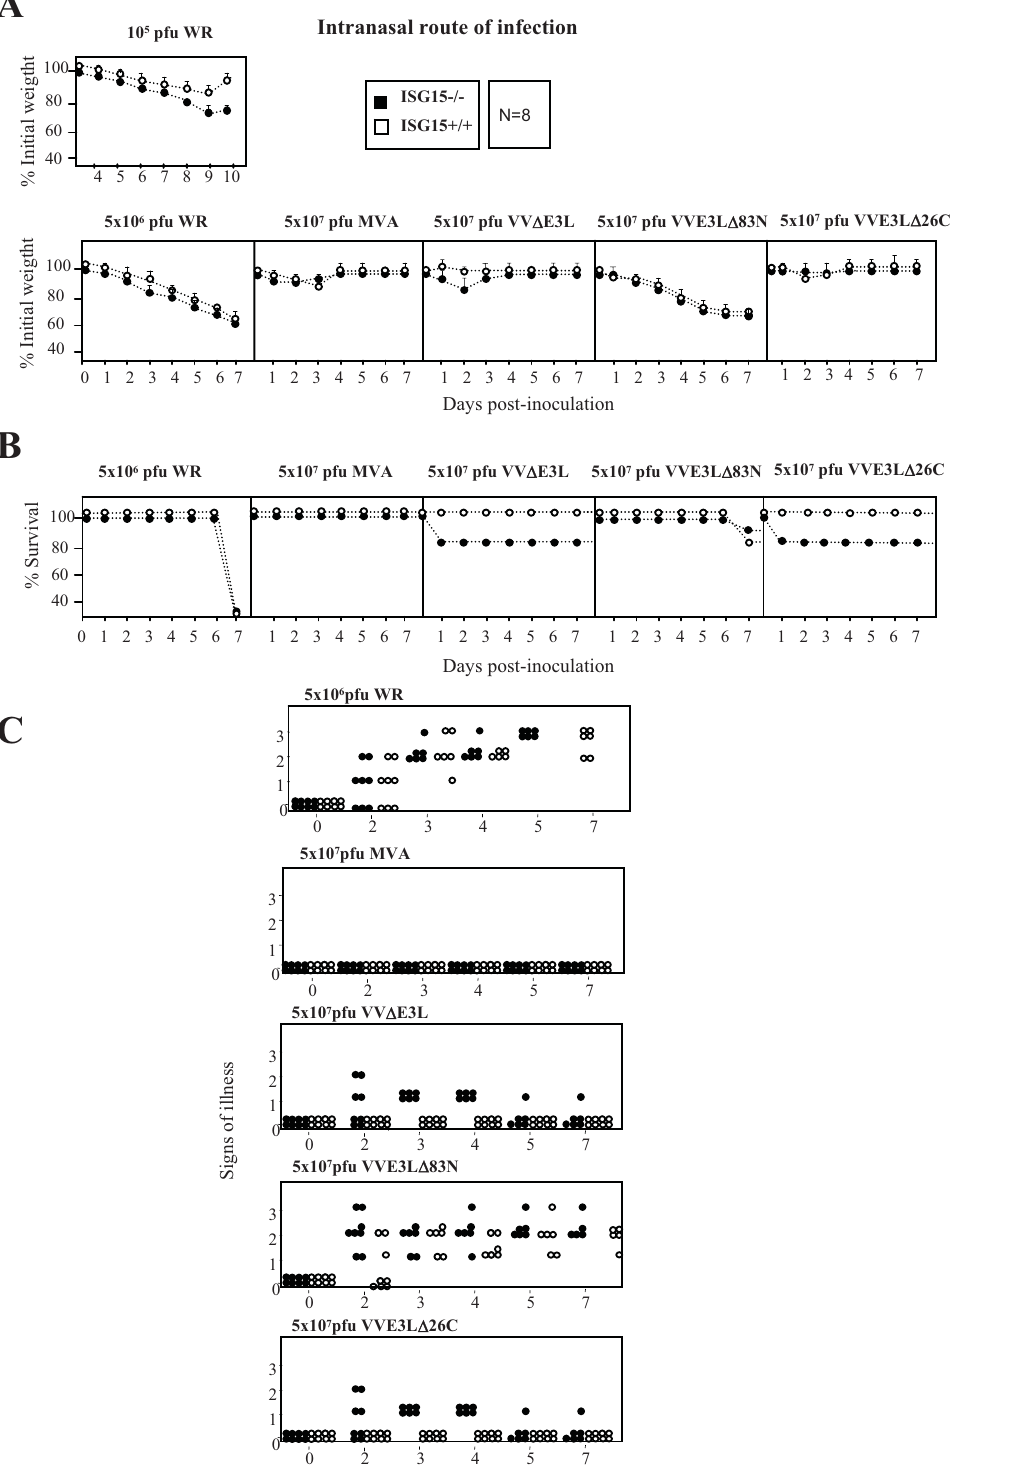
Figure 8. Virulence of different VACV strains after infection of ISG15 + / + and ISG15 2 / 2 mice. A . Mice were inoculated i.n with purified WR (10 5 or 5 6 10 6 PFU/mouse) or VV D E3L (5 6 10 7 PFU/mouse) or VVE3L D 83N (5 6 10 7 PFU/mouse) or VVE3L D 26C (5 6 10 7 PFU/mouse). Mice were individually weighed daily, and mean percentage weight loss of each group (n=8) was compared with weight immediately prior to infection. B . Survival rate after i.n inoculation as described in A. Dead animals were scored daily and represented as the percentage of surviving animals. P # 0.01 in all experiments. C . Mice were inoculated as described above and for each individual signs of illness such as ruffled fur and lack of activity were monitored with time and are given in arbitrary units. P # 0.01 in all